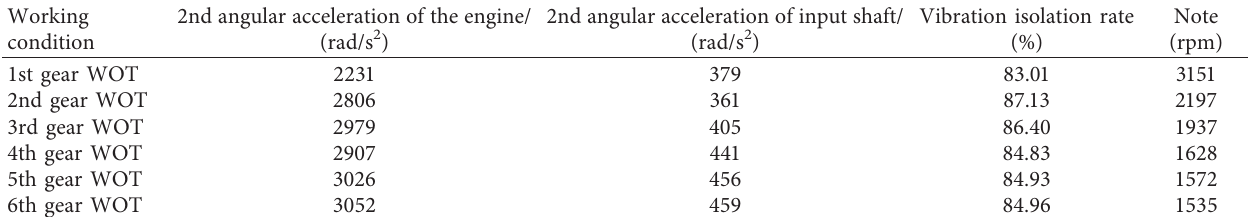
Table 6: Actual test results of loading after